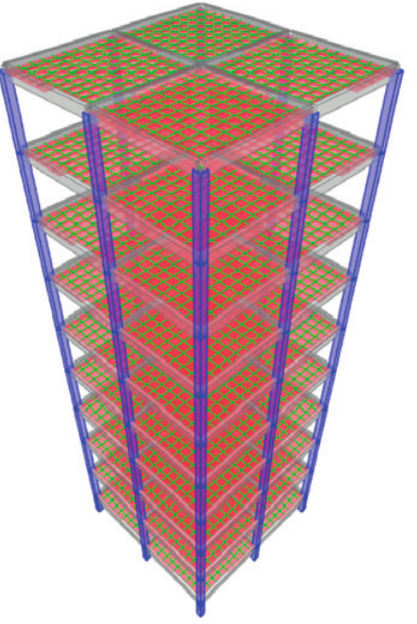
obtained using SAP2000 e through λ